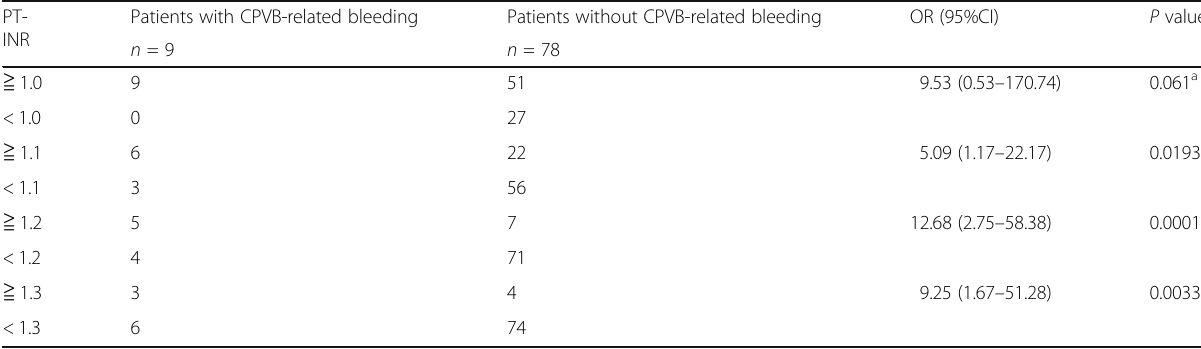
Table 3 Relationship between PT-INR- and CPVB-related bleeding PT- Patients with CPVB-related bleeding Patients without CPVB-related INR